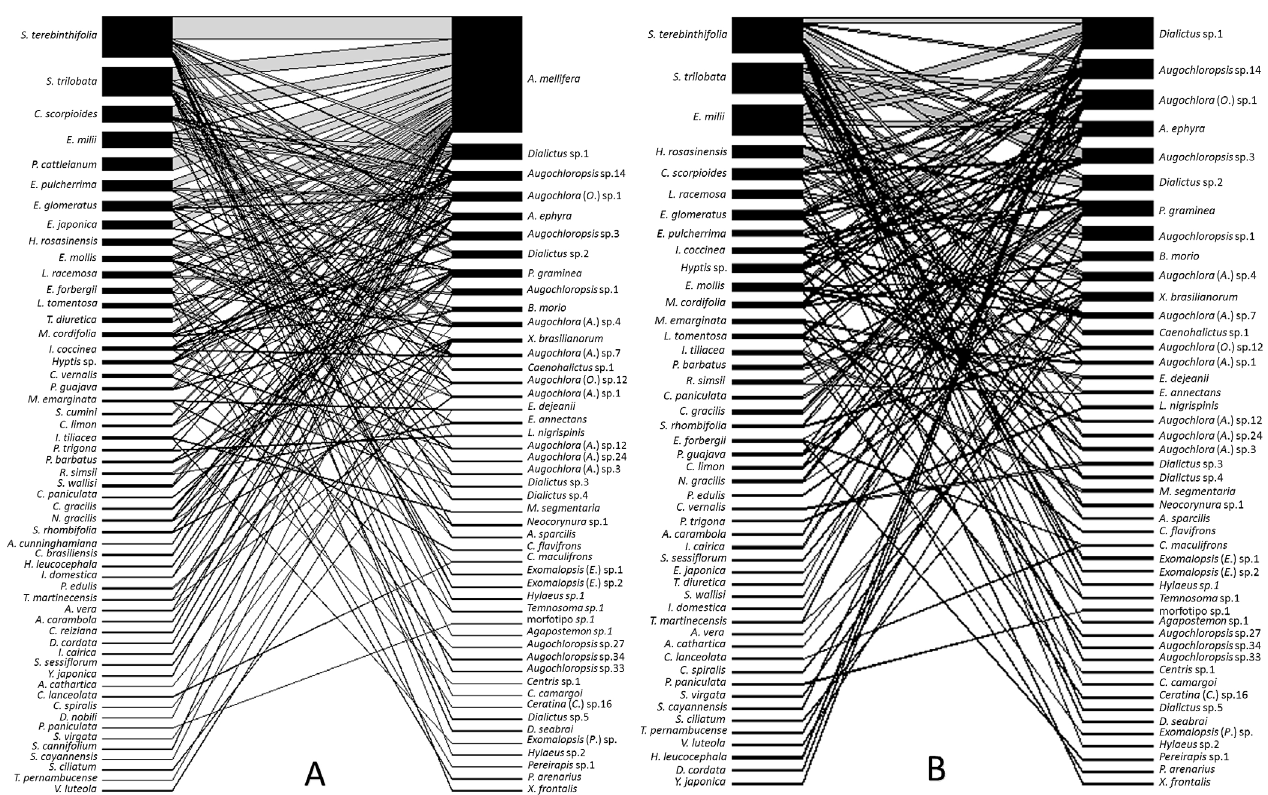
Fig 6 . Network of interactions between bees and plants from Ilha Grande, São Francisco do Sul, SC. Caption: A = with A. mellifera ; B = without A. mellifera